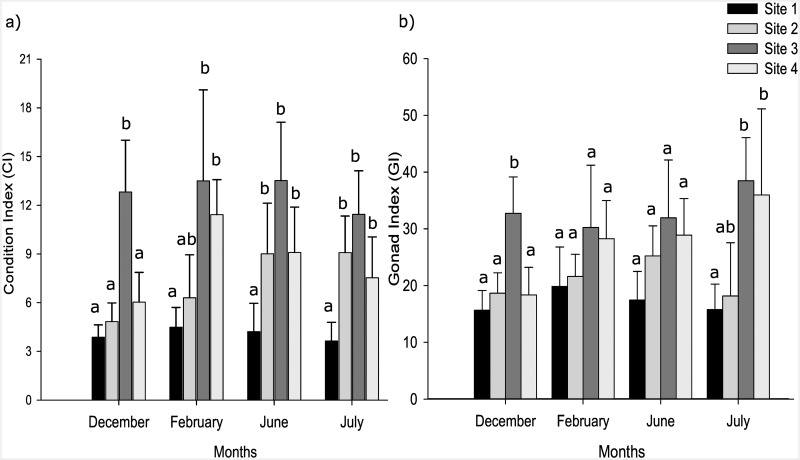
a) Condition Index and b) Gonad Index of Mytilus galloprovincialis at the four sites and across the four months sampled (n = 26 and n = 6 for CI and GI, respectively). Sites are arranged from south to north (left to right). Values are means, the error bars indicate standard deviations. Letters indicate homogenous groups within months (p > 0.05).